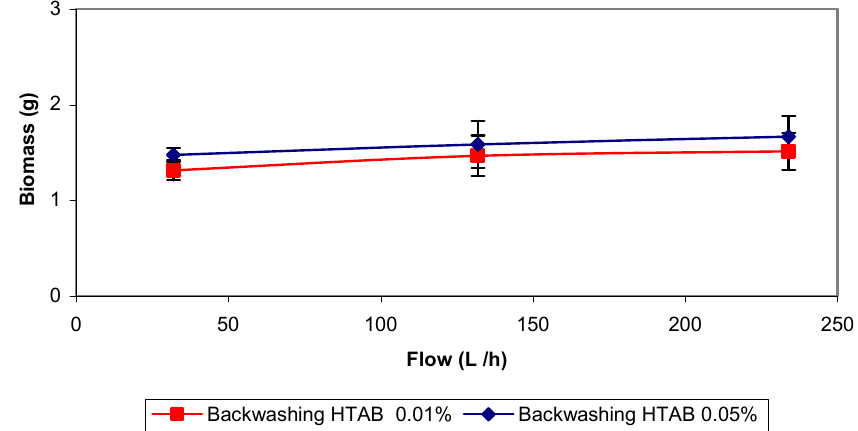
Figure 8. Backwashing treatment with cationic detergent (HTAB).